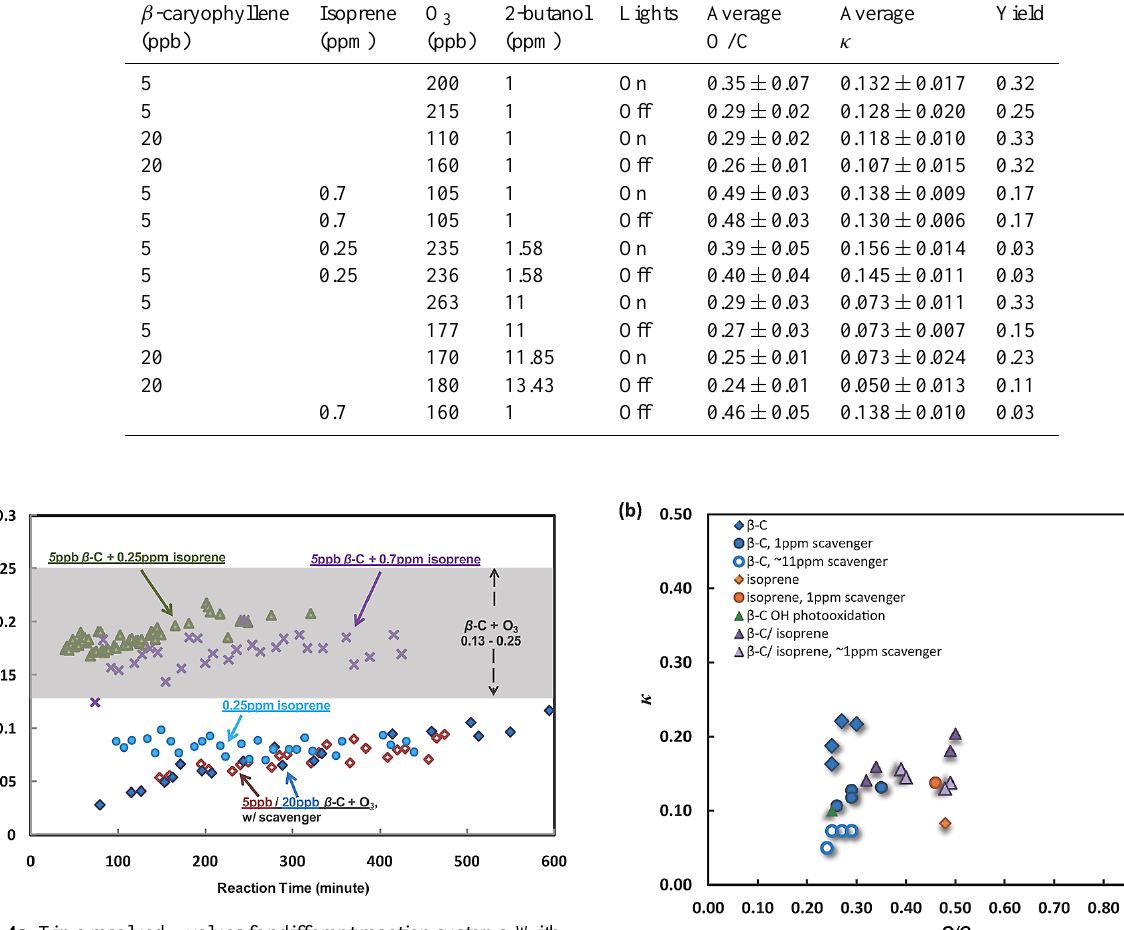
Fig. 4a. Time resolved κ values for different reaction systems. With- out OH scavenger, κ of β -C SOA ranged from 0.13 to 0.25 (shade area) with no significant change during the period of each experi- ment.